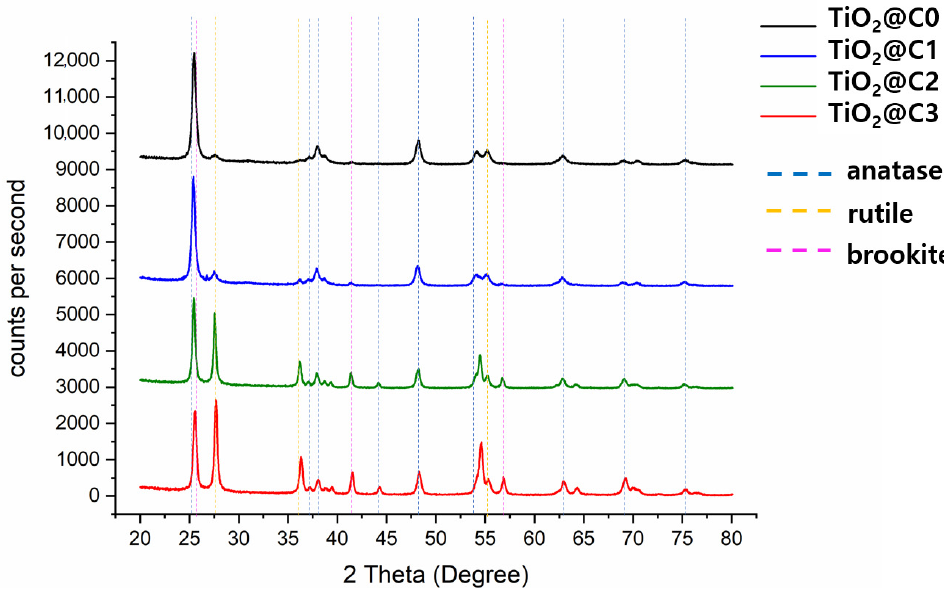
Table 3. Relative composition of crystalline phases and NO removal (%) of TiO 2 @C1, TiO 2 @C2, TiO 2 @C3, and TiO 2 @C0.